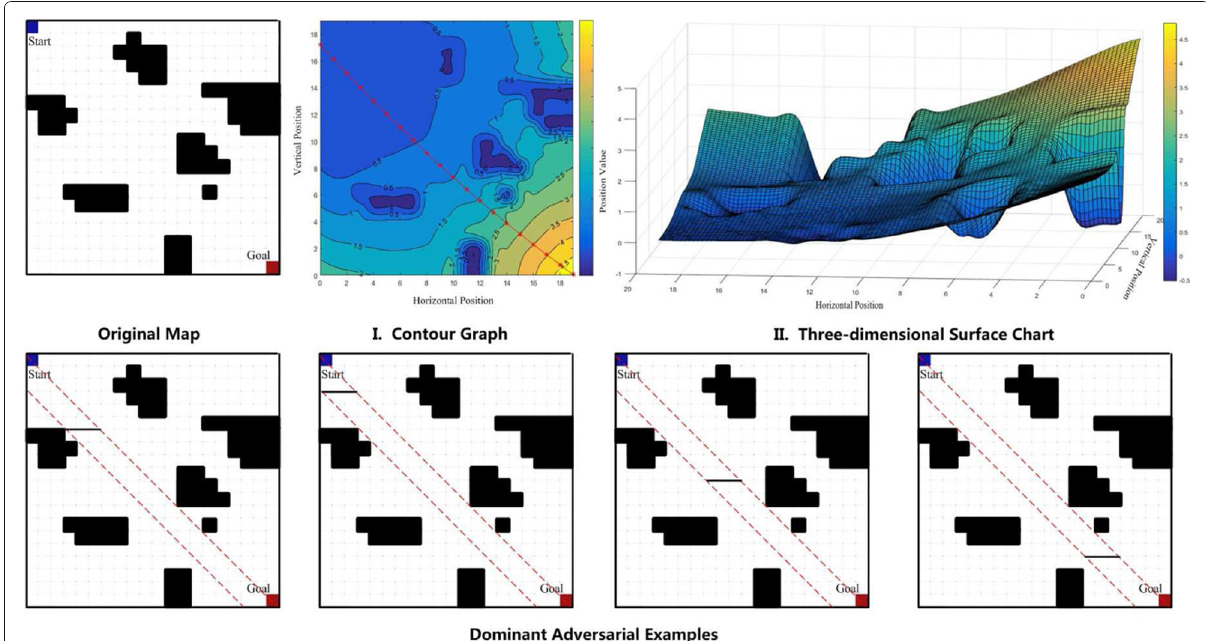
Fig. 4 The first line shows dominant adversarial examples for the original map. The fist picture denotes the original map for attack, and the three columns on the right are the dominant adversarial examples of successful attacks. Meanwhile, the red dotted lines represent the perturbation band. The second line denotes the direction in which the value gradient rises the fastest. By comparison between dominant adversarial examples and the contour graph, can found that on the perturbation band, the value gradient rises